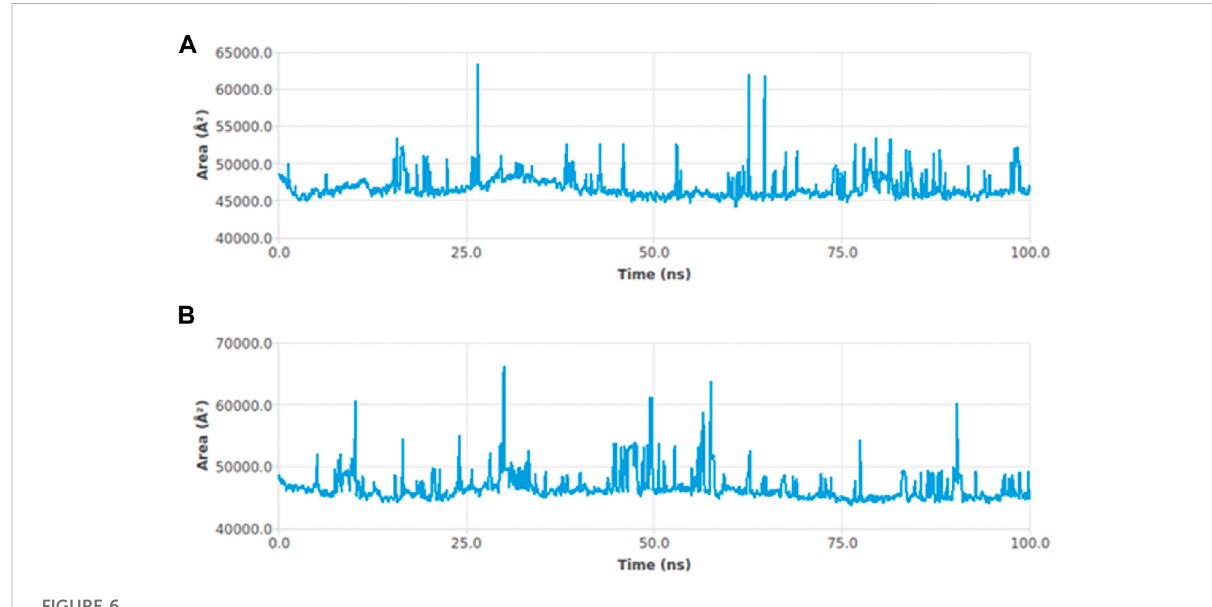
FIGURE 6 SASA curves highlighting the changes in the solvent accessibility of the studied protein complexes hTERT – adapalene (A) and hTERT – tamsulosin (B) ) during 100-ns MD